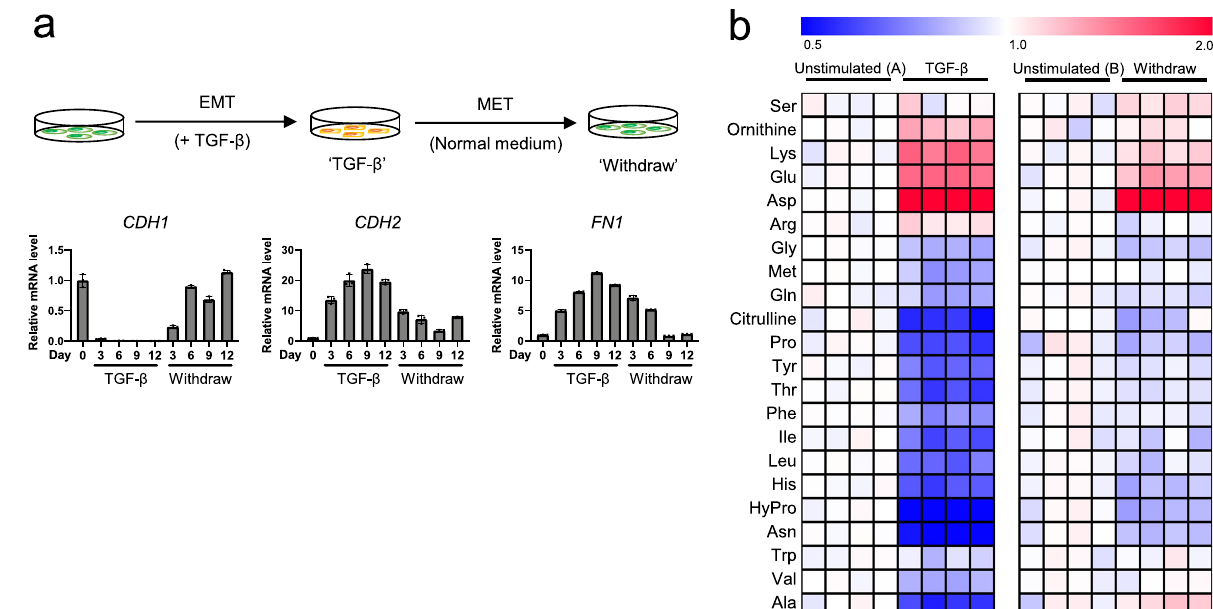
Fig. 2 Reversible EMT responses induced by TGF- β . a Reversible EMT marker changes induced by TGF- β in A549 cells. A549 cells were stimulated with TGF- β (2 ng/mL) for the indicated number of days (marked TGF- β ). After 12 days, the cells were washed with PBS and subsequently cultured in normal growth medium without TGF- β for 3, 6, or 9 days (marked Withdraw). The cells were passaged for 3 days. mRNA levels of EMT markers CDH1 , CDH2 , and FN1 were measured by real-time PCR. Values are presented as mean ± SD from triplicate samples. b TGF- β -induced reversible changes in amino acid levels in A549 cells. ‘ TGF- β ’ , A549 cells stimulated with TGF- β (5 ng/mL) for 3 days, washed with PBS and subsequently cultured in regular medium without TGF- β for 3 days ( ‘ Withdraw ’ ). Controls were cultured in normal growth medium for 3 days ( ‘ Unstimulated (A) ’ ) and 6 days ( ‘ Unstimulated (B) ’ ) for TGF- β stimulation and withdrawal, respectively. The medium for ‘ Unstimulated (B) ’ was changed to fresh normal medium after culturing for 3 days, as well as for ‘ withdraw ’ cultures. Metabolite levels in each sample were converted to a fold-change relative to the average metabolite level of the paired non-stimulation. Red and blue indicate higher and lower levels, respectively, of metabolites in TGF- β -stimulated cells compared to those in the unstimulated cells